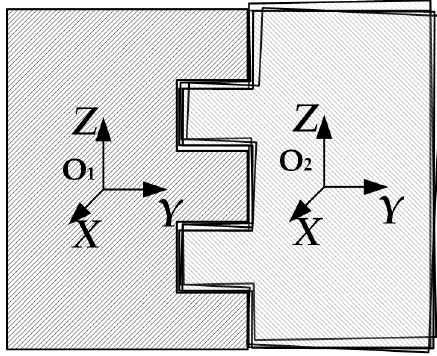
Figure 2. The pose variations under the condition of assembly accuracy requirements.